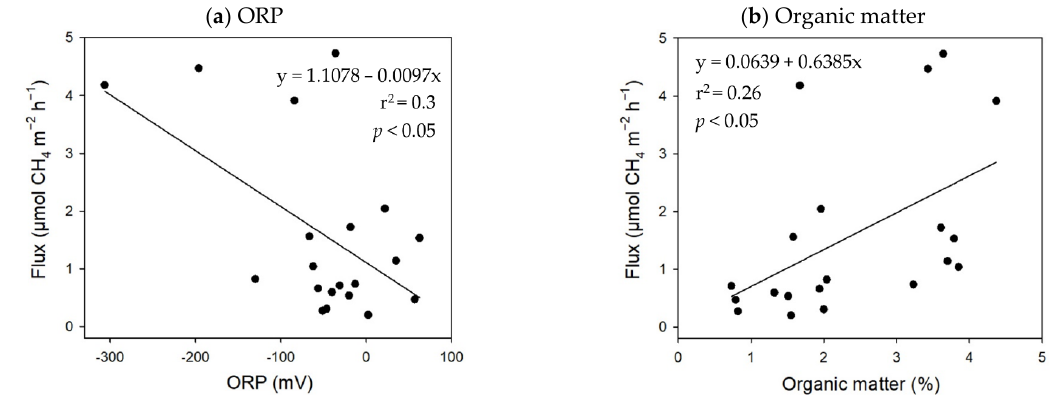
Figure 6. The relationships between the soil ( a ) ORP and ( b ) organic matter with CH 4 flux in the mudflats (n = 20).